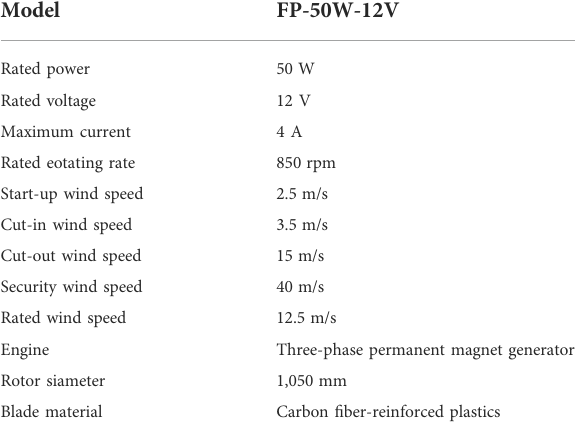
TABLE 2 Technical parameters of the wind